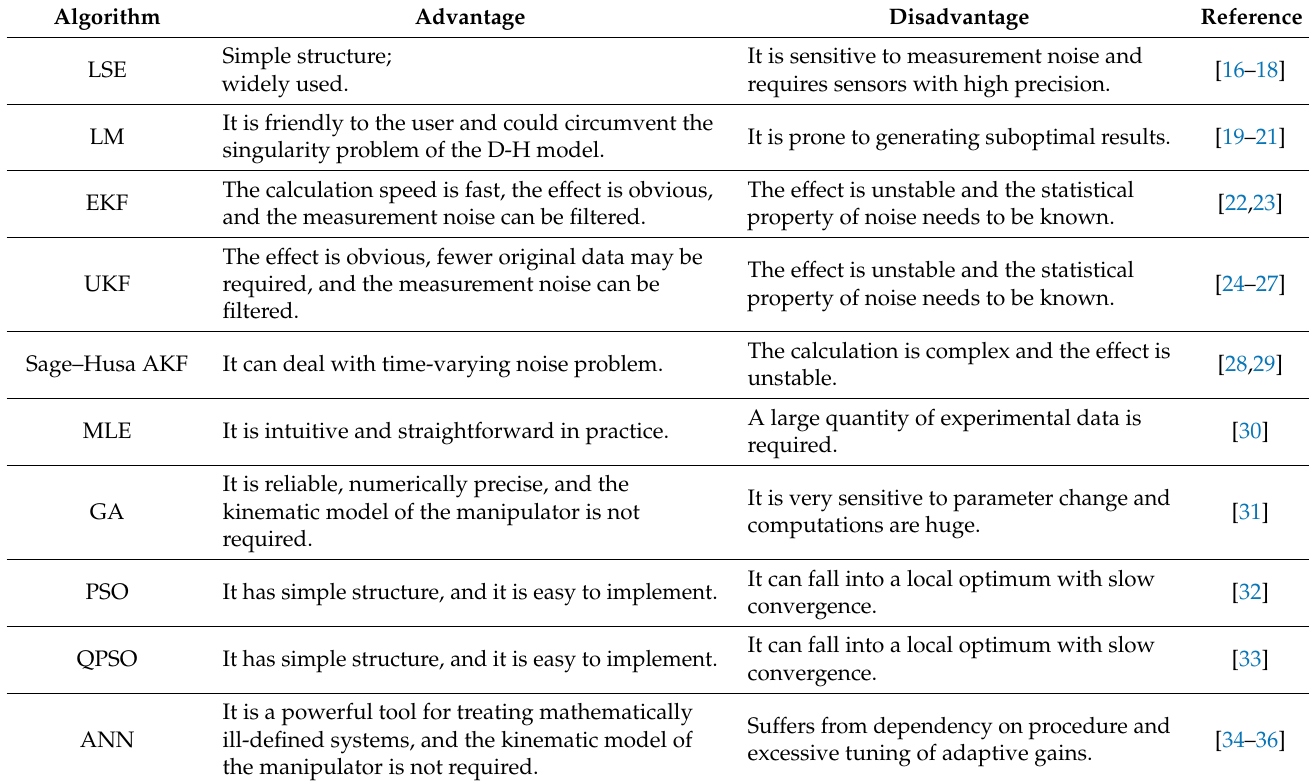
Table 1. Calibration algorithms and their advantages and